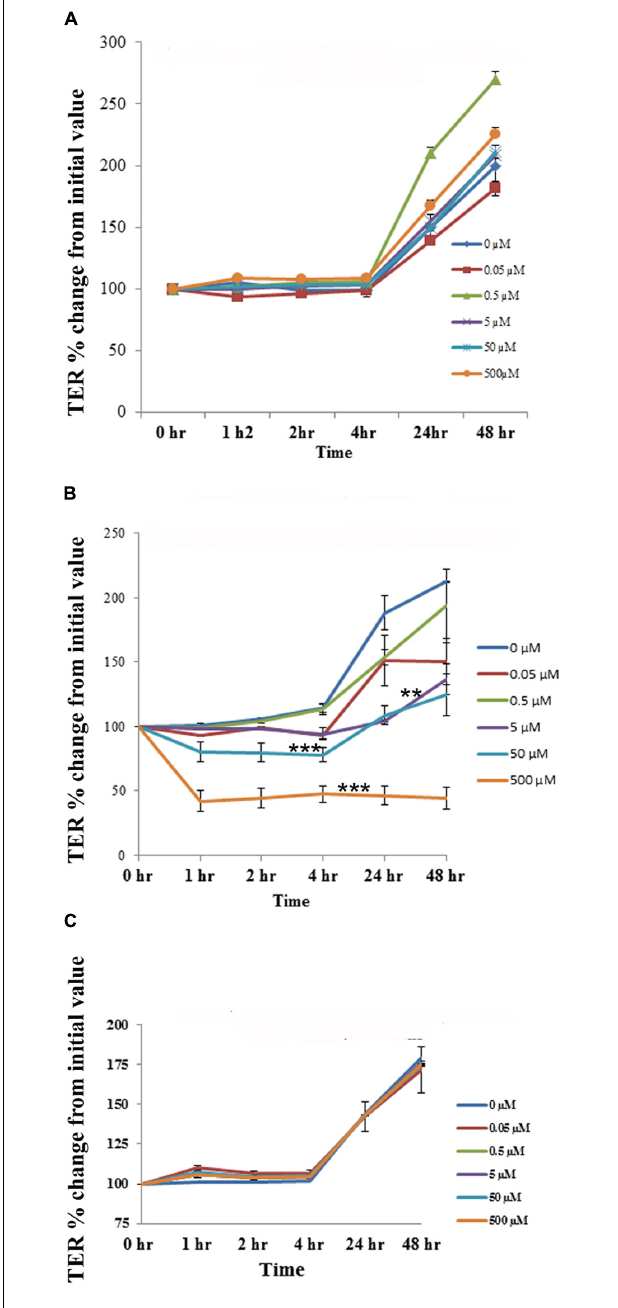
FIGURE 8 | The effect of aloin on the permeability of human intestinal epithelial cells. T84 cells were grown in transwells till a TER value of 1,000 or above was reached. The TER value was recorded before and after incubation with five concentrations of aloin (0.05, 0.5, 5, 50, and 500 µ M) at 0, 1, 2, 3, 24, and 48 h. The TER values recorded before adding aloin served as a baseline value. Data are presented here as % increase or decrease from the baseline readings. These data represent an average of seven independent experiments. The asterisk ∗ indicates statistical significance. (A) This graph shows the TER value for aloin dissolved in pH 7.2. (B) It shows the TER value for aloin dissolved in pH 4.9 citrate buffer and further diluted in cell culture media (antibiotic free media). (C) TER value for aloe-emodin. Asterisks indicates statistical significance ( ∗ p < 0.05, ∗∗ p < 0.01, ∗∗∗ p <